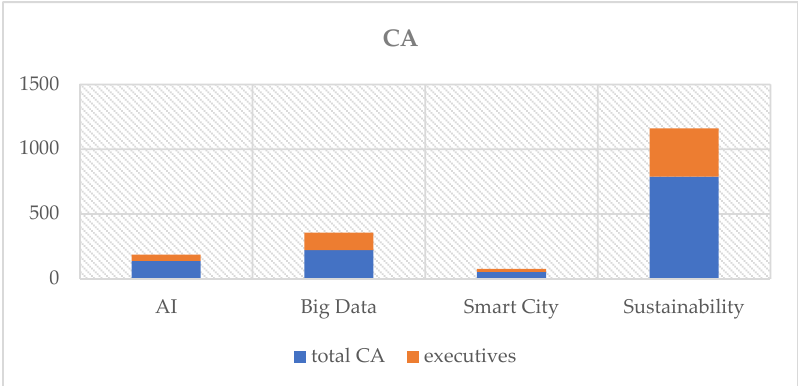
required: the total number and the number of job posts for executives.